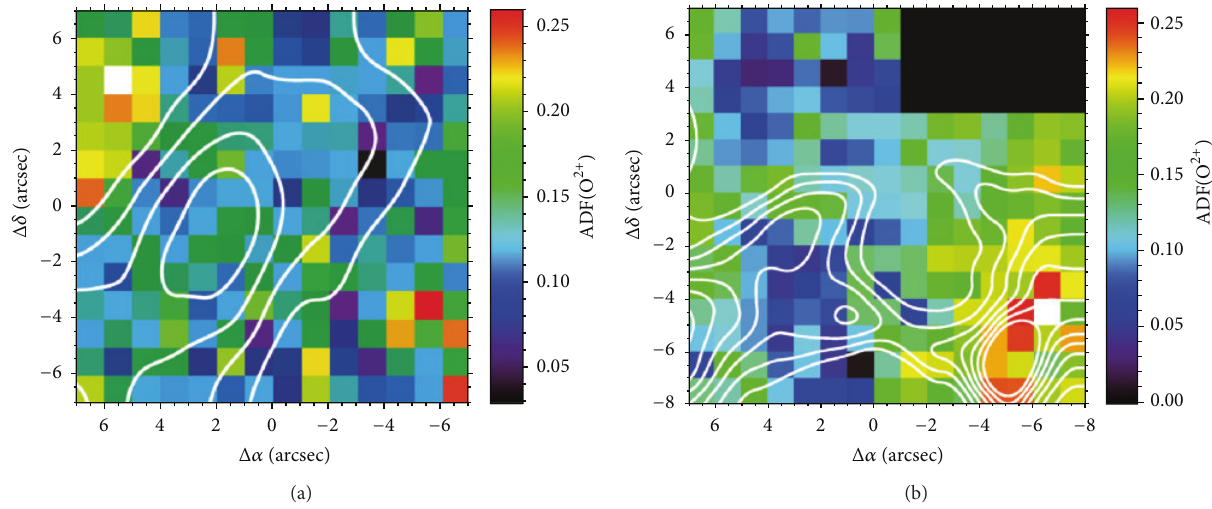
Figure 7: Spatial distribution maps of ADF ( O 2+ ) with H 𝛼 contours overplotted for (a) NE-Orion-S and (b) HH202, adapted from [37, 54], respectively. The black rectangle in the upper-right corner of HH202 corresponds to a masked area where O II RLs were marginally